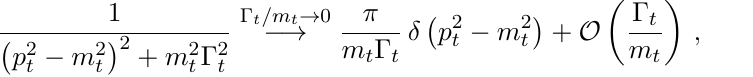
Figure 1 . Schematic illustration of the decay chain for the pp process. The dashed lines indicate top quark and W gauge boson propagators which are treated as on-shell particles in the